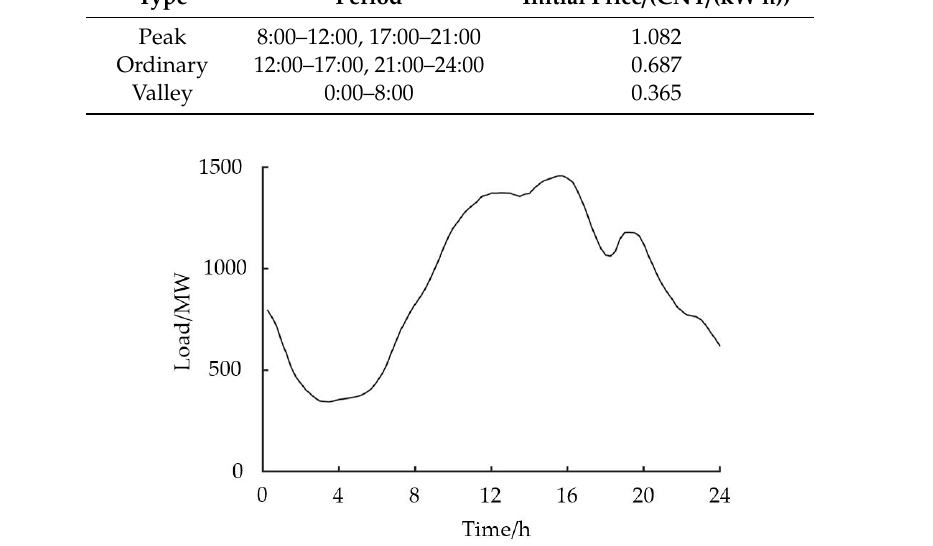
Figure 3. Base load curve of grid.